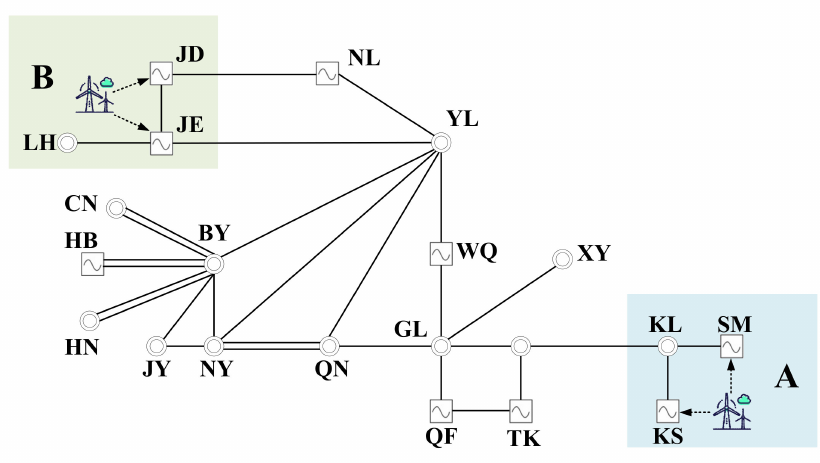
Figure 5. The network topology of the power